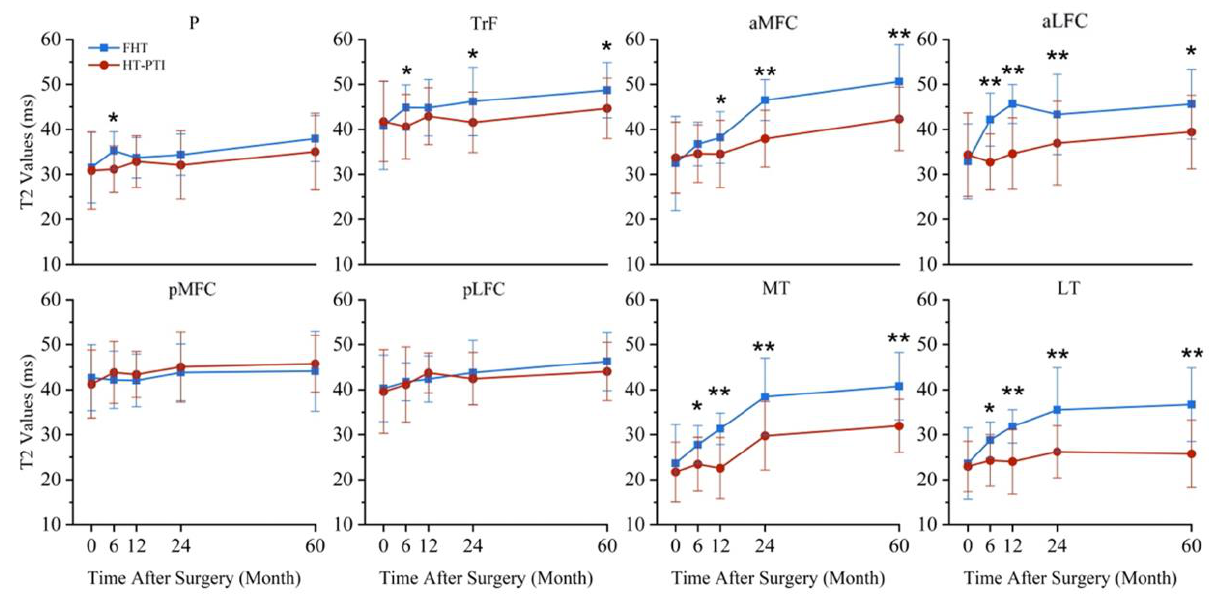
Figure 7. The T2 values of cartilage in each subregion were compared between FHT group and HT- PTI group. There was no significant difference in T2 value between the two groups before operation; The difference of P T2 value between two groups was significant at 6 months after operation; The differences of TrF T2 values between two groups were significant at 6, 24 and 60 months after operation; The differences of aMFC T2 values between two groups were significant at 12, 24 and 60 months after operation; The T2 values of aLFC, MT and LT between two groups were significantly different within 60 months after operation. * p < 0.05; ** p < 0.001. FHT, free hamstring tendon; HT-PTI, hamstring tendon with intact tibial insertion; P, patella; TrF, femoral trochlea; aLFC, anterior area of lateral femoral condyle; pLFC, posterior area of lateral femoral condyle; aMFC, anterior area of medial femoral condyle; pMFC, posterior area of medial femoral condyle; LT, lateral tibia plateau; MT; medial tibia